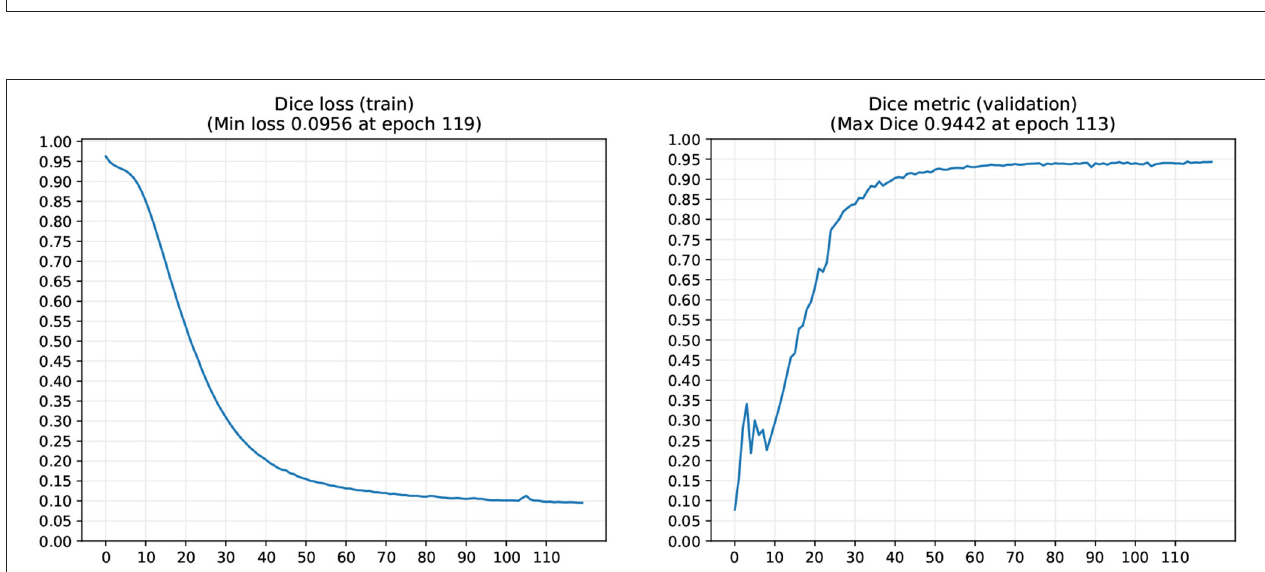
FIGURE 4 | IE-Vnet training loss and validation metrics. IE-Vnet training loss (left graphic) and validation (right graphic) metrics were observed during 120 epochs of training. In addition, the maximum validation Dice overlap metric of 0.944 was obtained at epoch 113. Notably, the loss curve showed a steady convergence toward the minimum obtained at the final iteration. At the same time, the validation metric showed a steady convergence without any signs of overfitting throughout the entire optimization procedure.